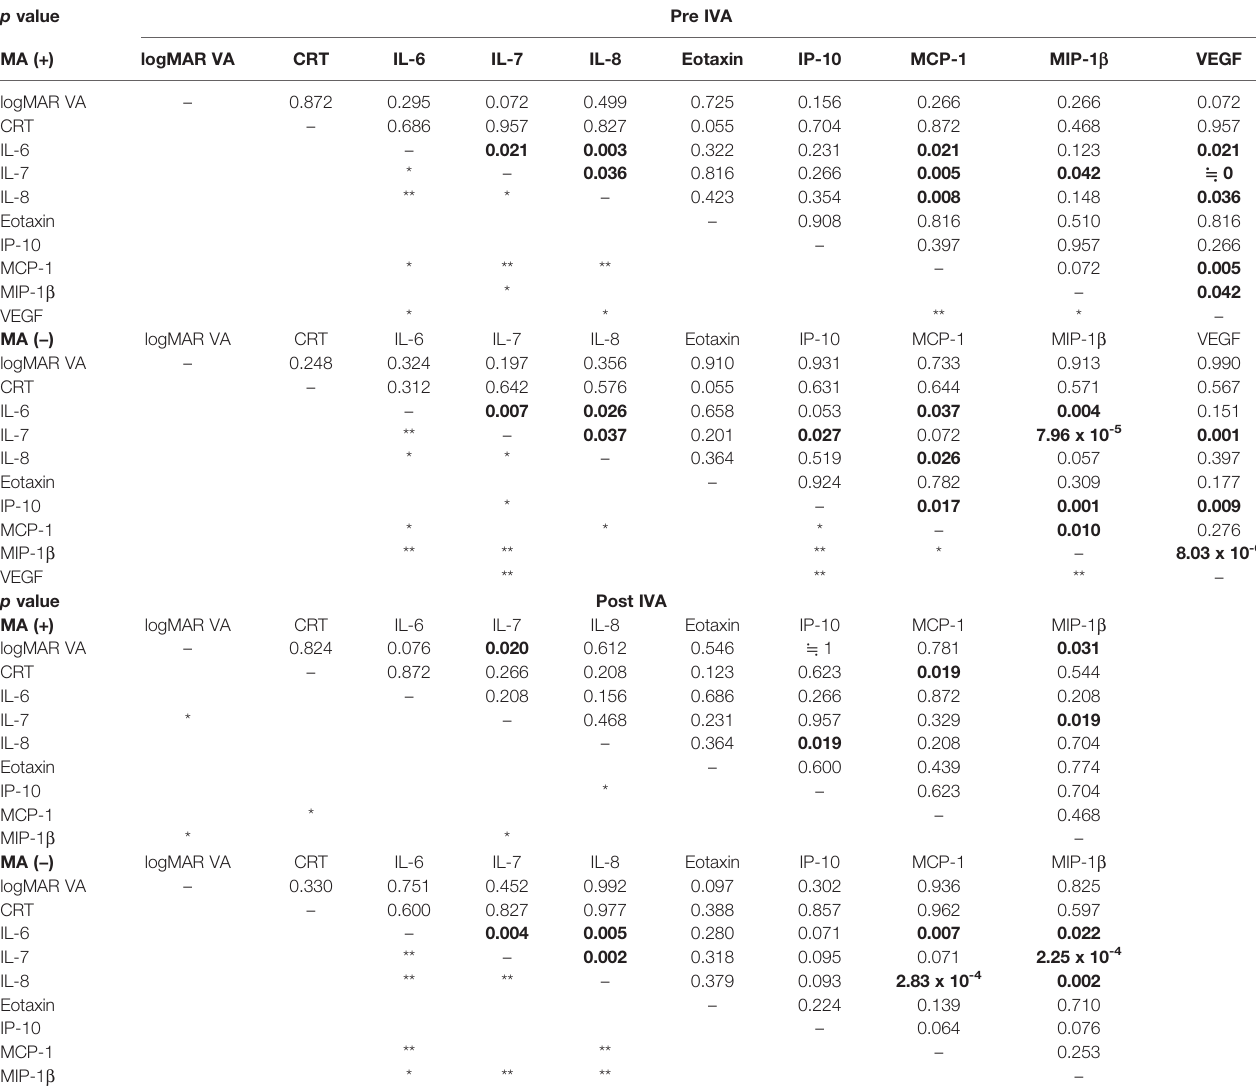
TABLE 3 | Correlation between aqueous humor cytokine levels and visual acuity or central retinal thickness in nAMD eyes with or without incidence of macular atrophy under a fl ibercept treatment. p value Pre IVA MA (+) logMAR